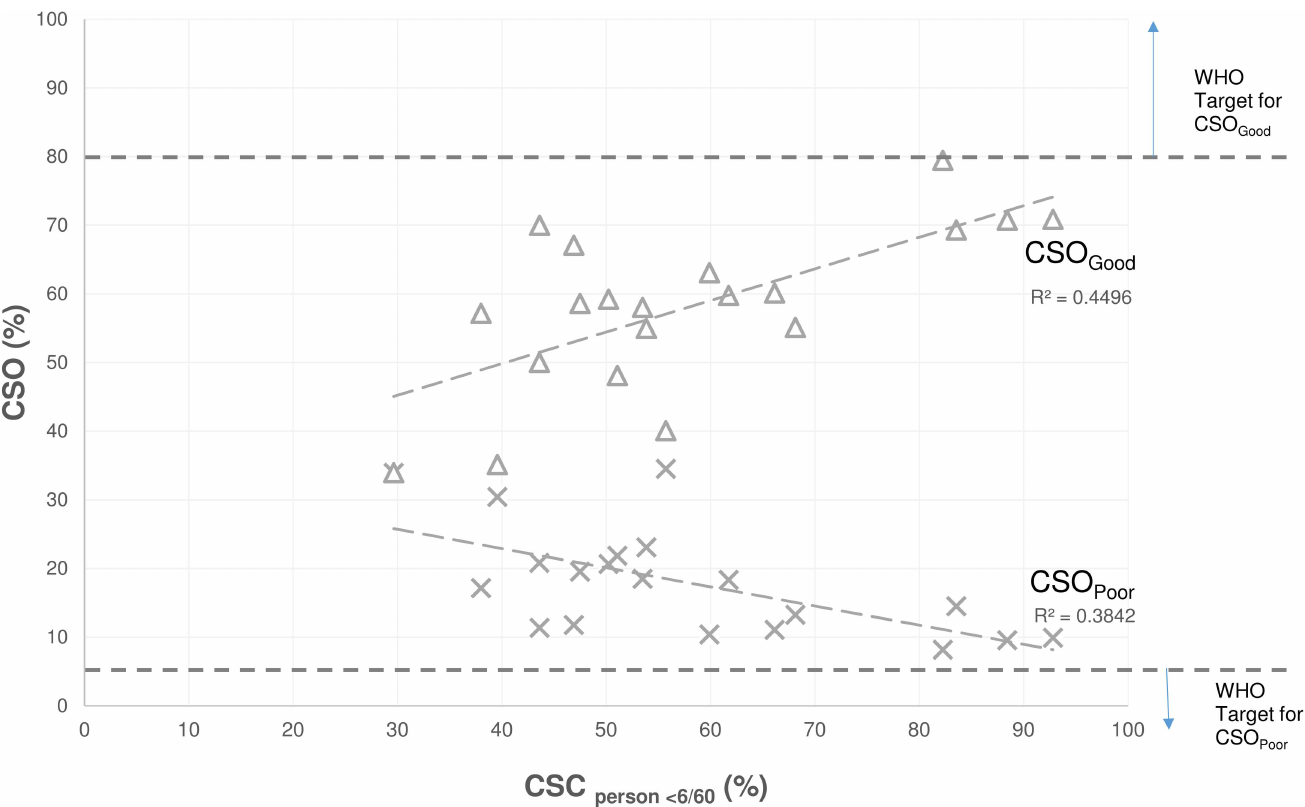
Fig 1. Proportion of operated eyes with presenting visual acuity of 6/18 or better (CSO Good ) or worse than 6/60 (CSO Poor ) plotted against observed cataractsurgical coverage(CSC persons < 6/60 , %) in 20 countries, 2005–2013. WHO Targets established in